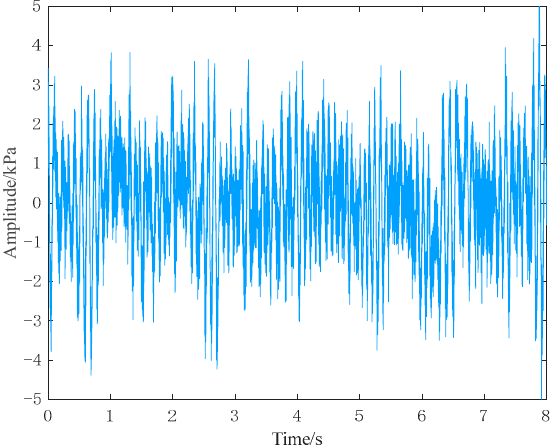
Figure 6. Original signal.